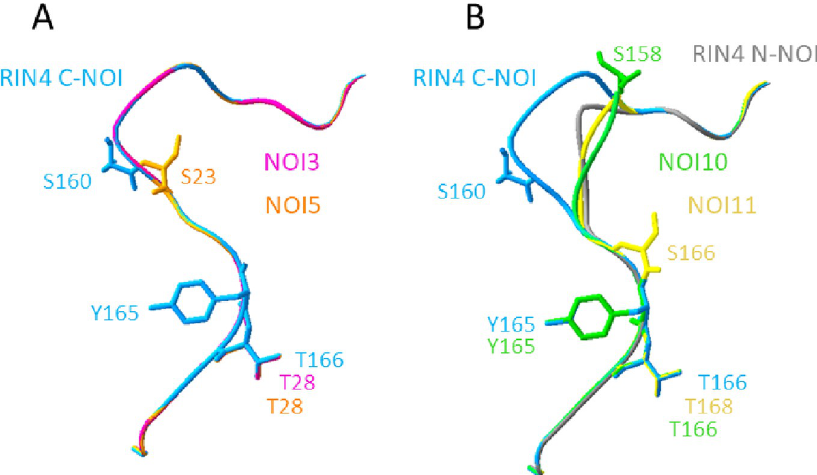
Fig 6. Structural features of the C-NOI domains of A . thaliana RIN4-like/NOI members. A) Comparison of RIN4 and the predicted structures of NOI3 and NOI5. B) Comparison of RIN4 and the predicted structures of NOI10, NOI11, and the N-NOI domain of RIN4. Predicted phosphorylated amino acids are shown in sticks.